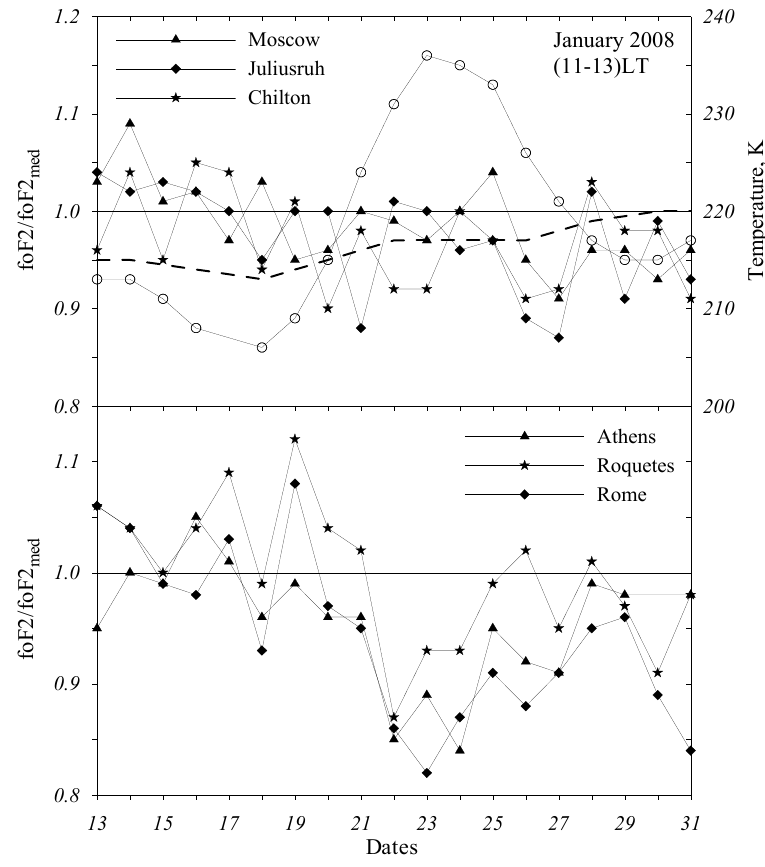
Figure 5. Same as Figure 2 but for the January SSW 2008 event. Rome observations are considered for the further analysis. Figure 6 indicates the f o F 2 depression depth of 25% (56% in N m F 2 ) with respect to the median level is. This is incom- parable to the magnitude of EUV variations—around 3%. MSISE00 model neutral gas density is seen to follow Ap index variations with a magnitude of ~19%, which is much less than the magnitude of the ρ variations (~52%) observed with CHAMP. Therefore, similar to the SSW 2009 event, both f o F 2 and neutral gas density manifest a pronounced depression in the vicinity of the SSW 2008 maximum development not related to EUV nor geomagnetic activity variations.